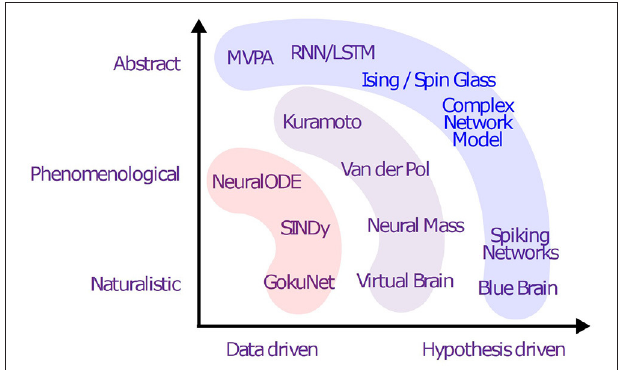
FIGURE 2 | Overview of generative models: well-developed models (blue), partially-explored approaches (purple), and modern pathways with little or no literature on neural data